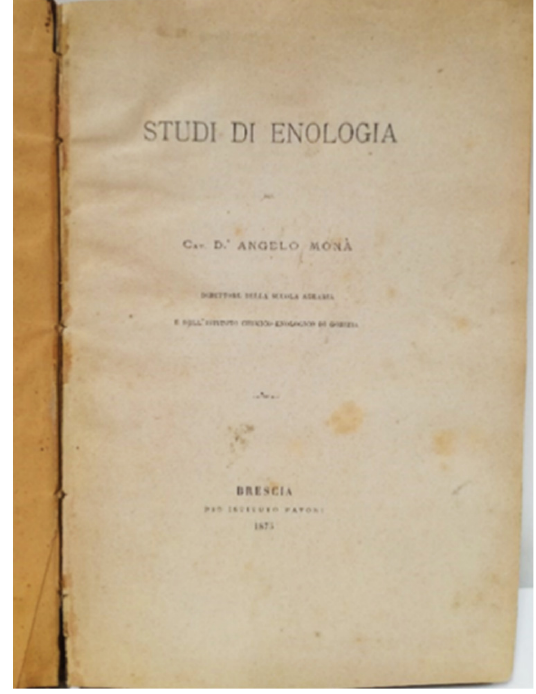
Figure 4. Photography of the title page of the analyzed book.